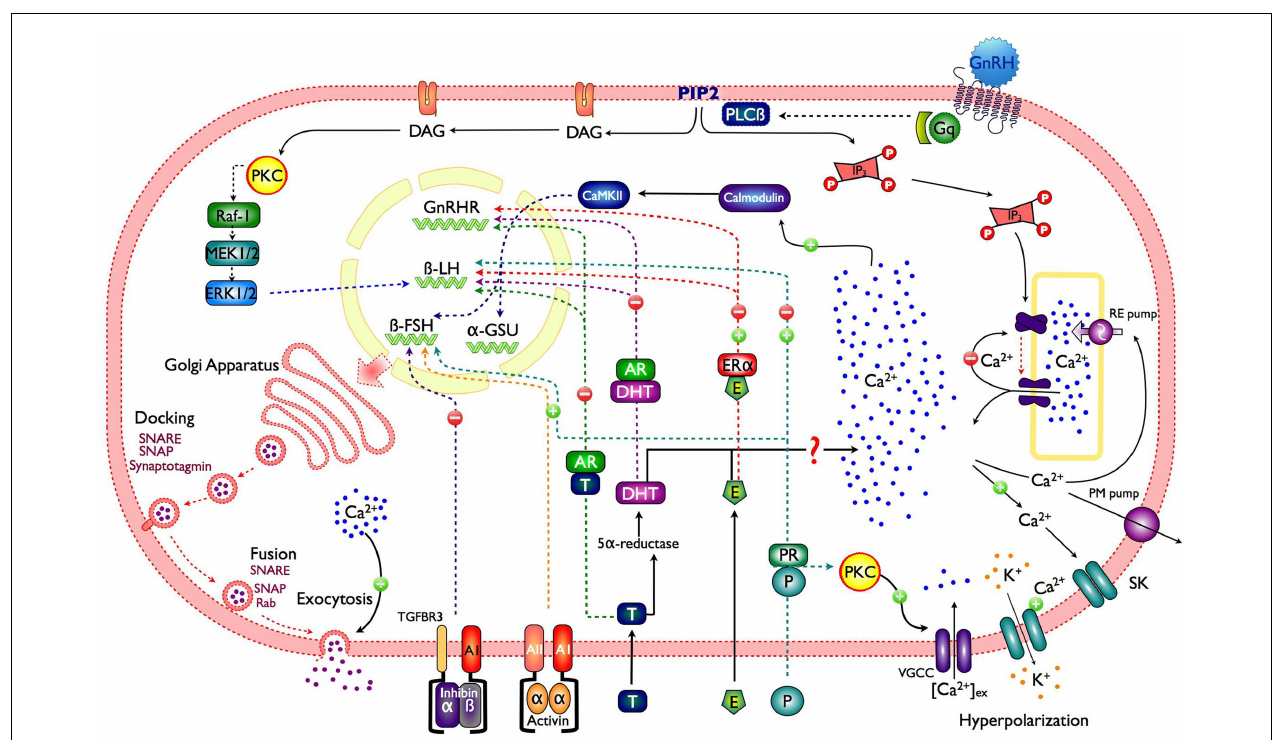
kinase; RE pump, endoplasmic reticulum Ca 2 + pump; PM pump, plasma membrane Ca 2 + pump; SK, small conductance calcium-activated potassium channels; P, progesterone; PR, progesterone receptor; E, estradiol; ER α , estrogen receptor α ;T, testosterone; AR, androgen receptor; Raf, serine/threonine kinase; MEK, mitogen-activated protein kinase; ERK, extracellular-signal-regulated